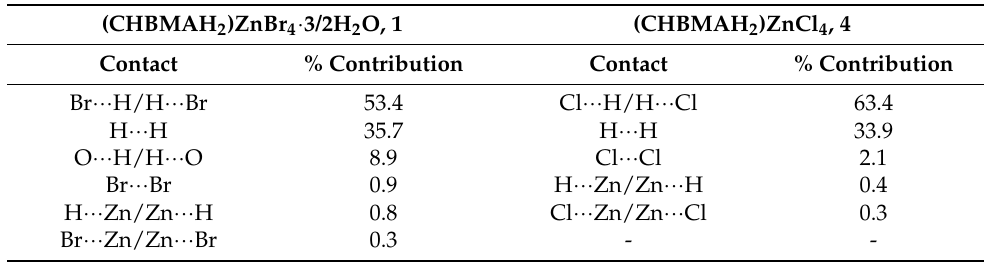
Table 4. Percentage contributions of interatomic contacts to the Hirshfeld surface for compounds 1 and 4 .